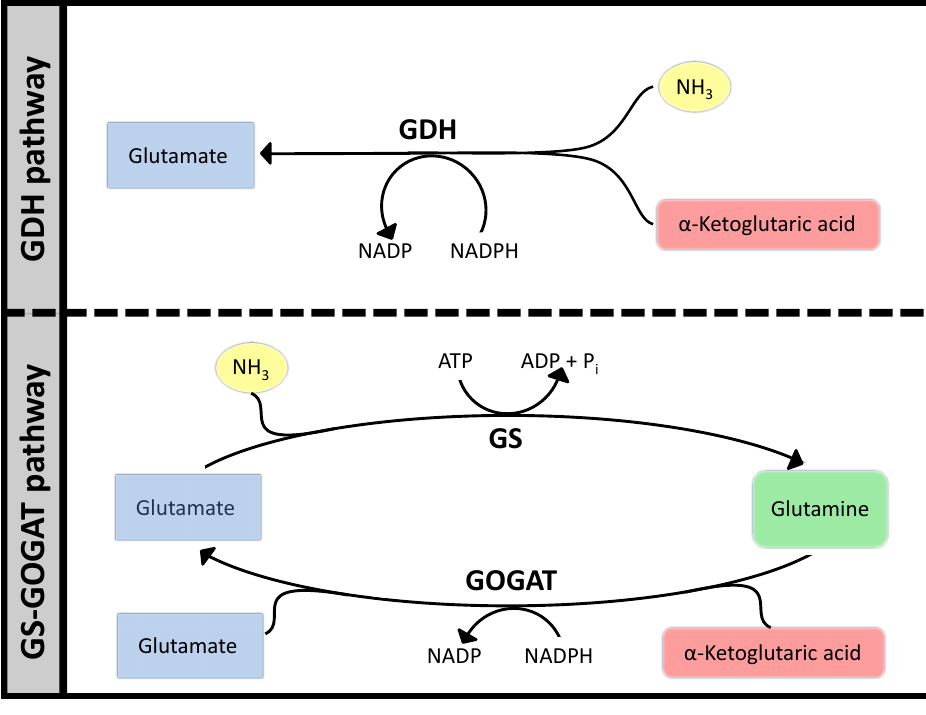
Figure 7. Two pathways for ammonia assimilation.